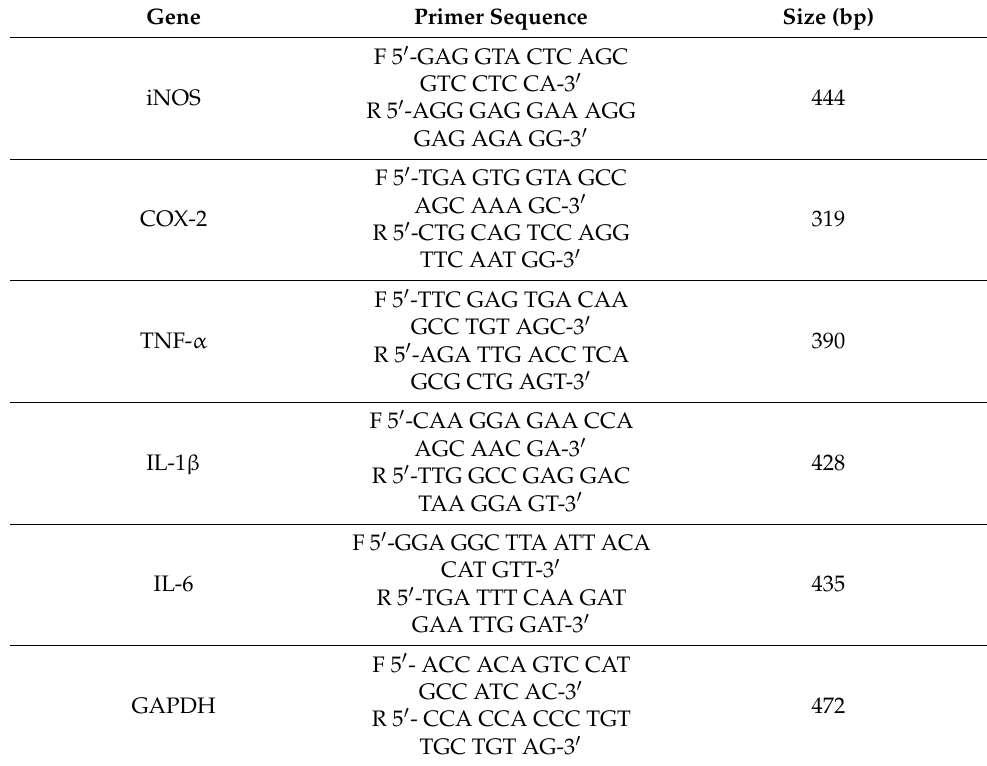
Table 1. Specific primer sequences used in this study. Gene Primer